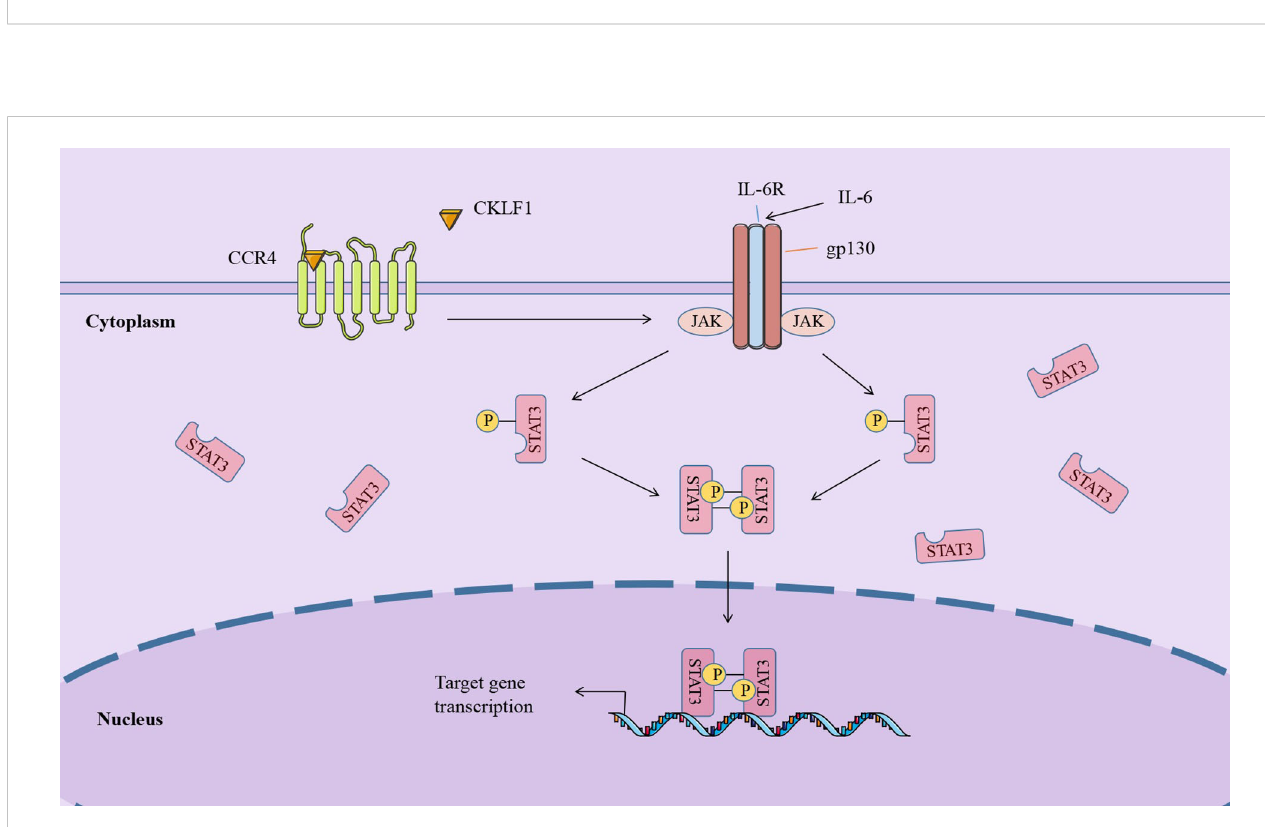
FIGURE 3 CKLF1 binds to CCR4 and induces the cell cycle regulatory gene expression through the IL-6/JAK/STAT3 signaling pathway, which is involved in tumor